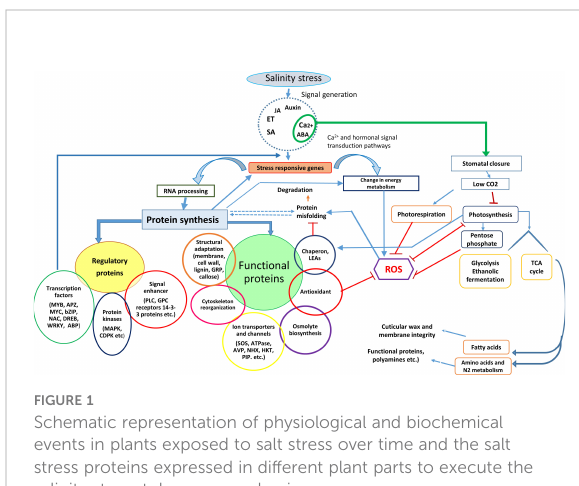
FIGURE 1 Schematic representation of physiological and biochemical events in plants exposed to salt stress over time and the salt stress proteins expressed in different plant parts to execute the salinity stress tolerance